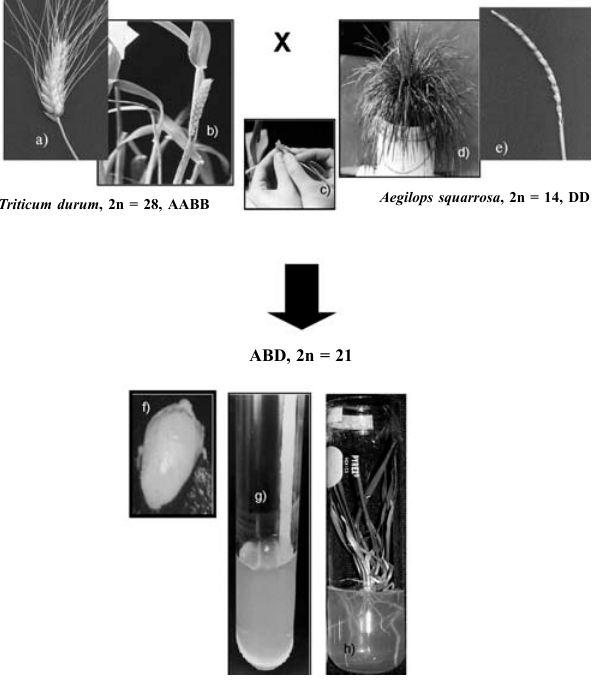
Figure 2 - For the experimental resynthesis of hexaploid wheat, a tetraploid species, Triticum durum , 2n = 28, AABB ( a ), is emasculated ( b and c ), and pollinated by Aegilops squarrosa , 2n = 14, DD ( d , e ). The hybrid embryo, 2n = 21, ABD needs to be rescued ( f , g ) for green plantlets regeneration ( h ) and genome duplication by colchine treatment (Figure